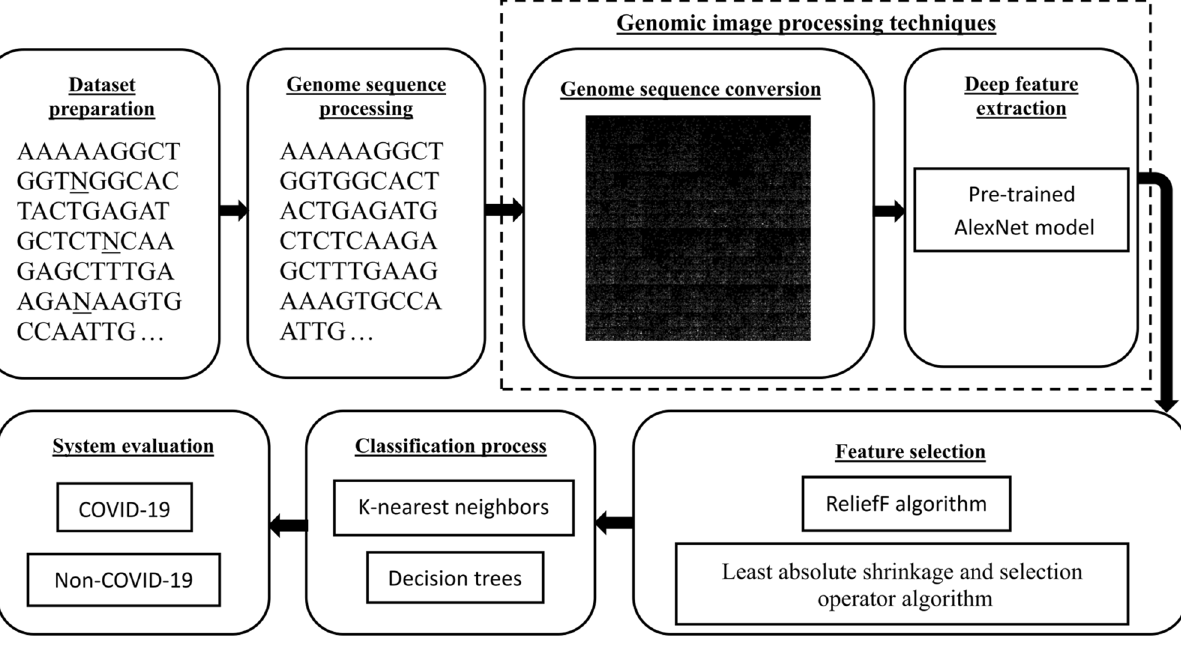
Figure 1. The proposed system block